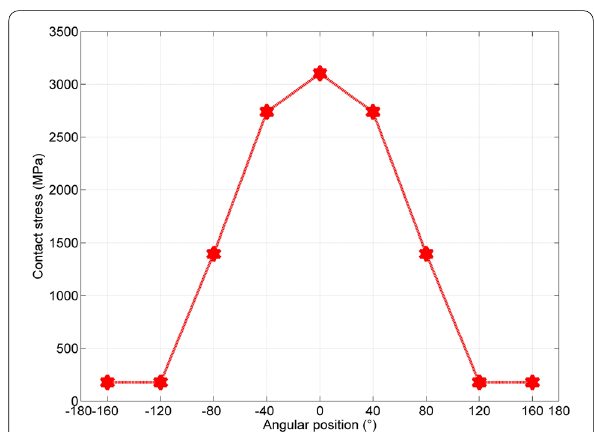
Figure 17 Contact stress distribution of inner raceway at the different angular